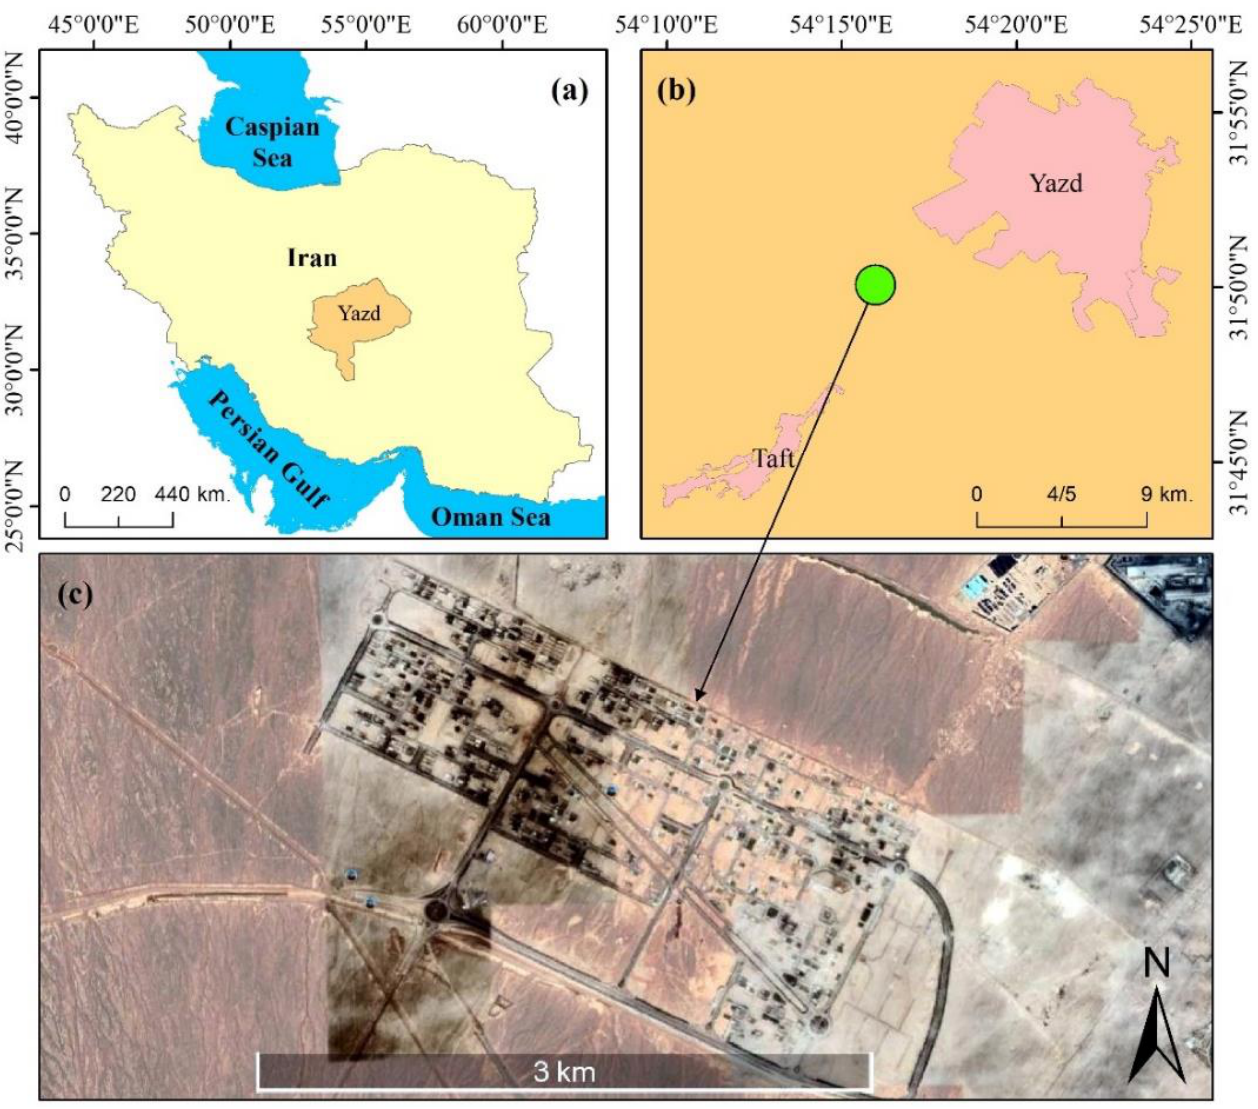
Figure 2. The location of the studied area in Yazd province and Iran ( a ), its location in between Yazd city and Taft city ( b ), and its 2023 Google Earth image ( c ).